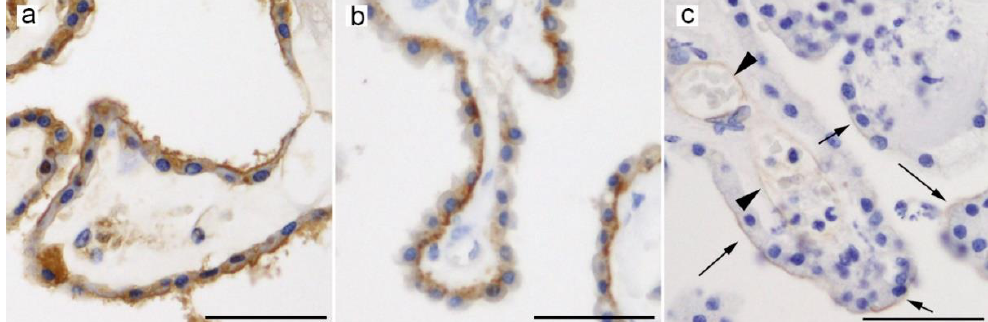
Figure 4. Representative microphotographs of immunohistochemical staining for ( a ) GLUT9 (ab104623, Abcam) [142], ( b ) URAT1 (BMP064, MBL, Nagoya, Japan) [142], and ( c ) BCRP/ABCG2 (clone BXP-21, ab3380, Abcam, 1:100, antigen retrieval with citrate buffer (pH 6)) in the human CP. ( a ) GLUT9 is mainly located in the apical side of CP epithelial cells. ( b ) Immunoreactivity for URAT1 is observed in the basolateral side of CP epithelial cells. ( c ) Along with endothelial cells in the CP parenchyma (arrowheads), BCRP/ABCG2 is expressed on the apical surface of CP epithelial cells (arrows). Scale bars: 50 μm.